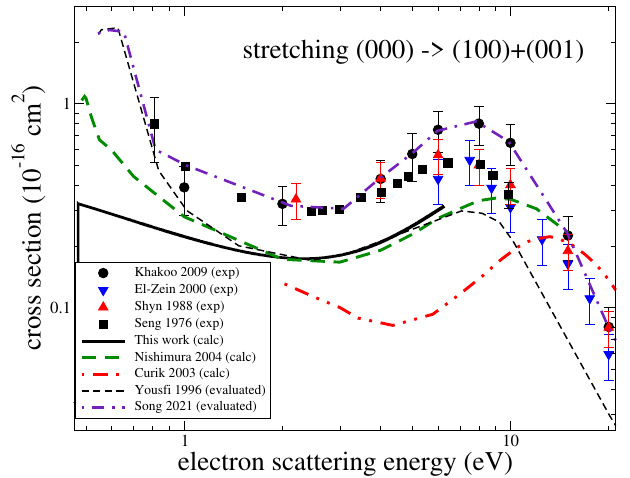
Figure 5. A comparison of cross sections available in the literature for the excitation of the stretching modes ( 000 ) → ( 100 ) + ( 001 ) . The black solid line is the theoretical result obtained in this study.